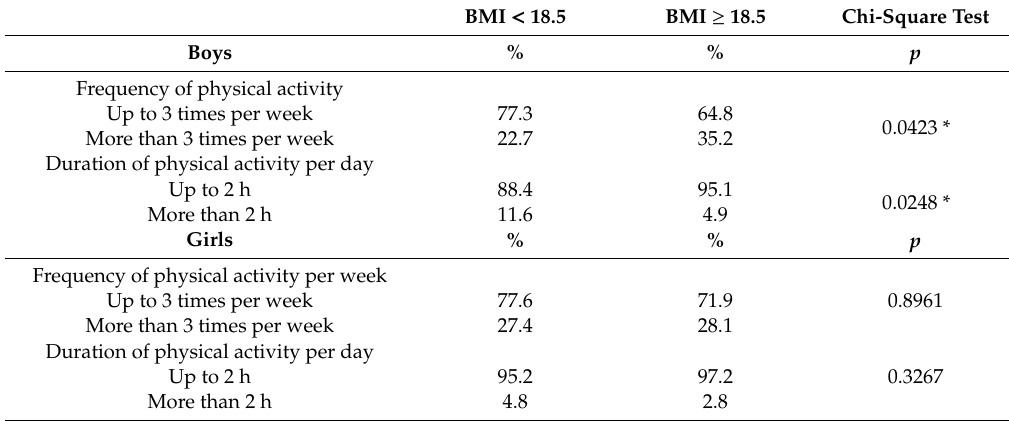
Table 5. The prevalence of frequency and the duration of physical activity in rural boys and girls with thinness (BMI < 18.5) and without (BMI ≥